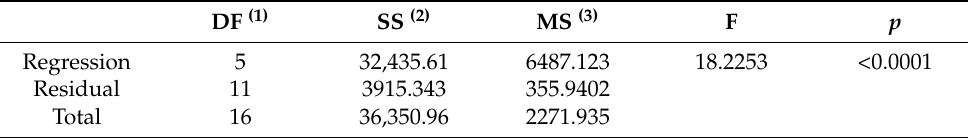
Table 3. Analysis of variance for hydrogen production rates.